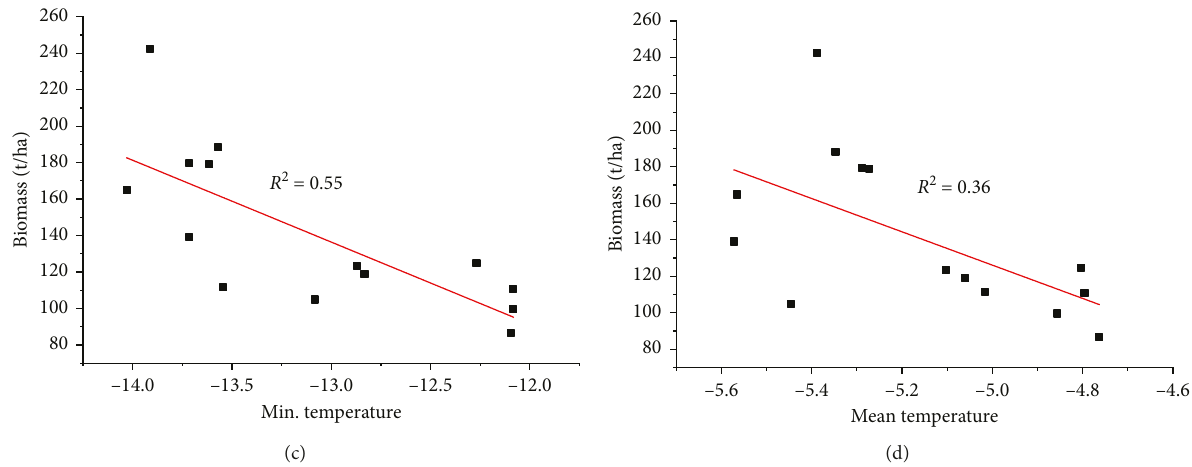
Figure 5: Relationship between Betula platyphylla stem biomass (SB) with > 430mm (PPT) along climatic gradients since 1950–2016: (a) annual precipitation; (b) annual maximum temperature; (c) annual minimum temperature; (d) annual mean temperature.